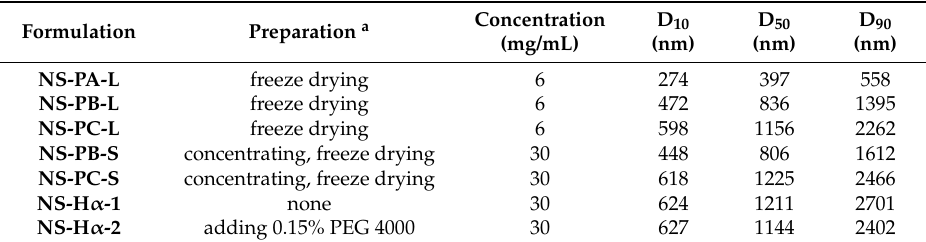
Table 2. Preparation, concentrations, and particle sizes.